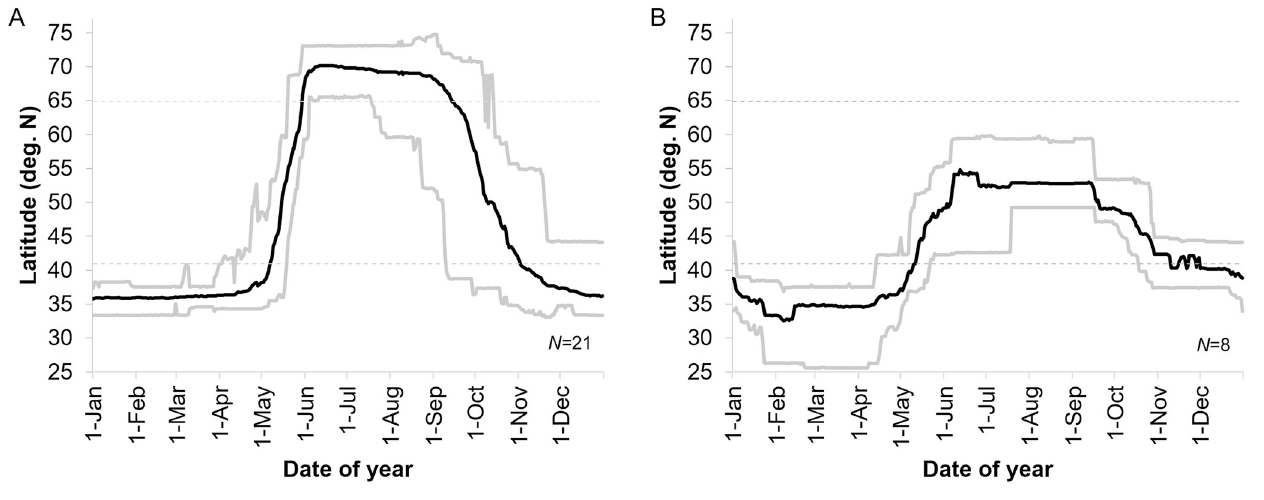
Fig 2. Seasonal changes in the latitudinal distribution of Vega gulls spending summer (A) within (above 64.9˚N) or (B) outside (below 60˚N) their known breeding range (the fixes of one bird were split between the two panels; see Methods). The black line shows the mean latitude of all birds for each day of the year while the grey lines show the maximum and minimum latitudes recorded during these days for single